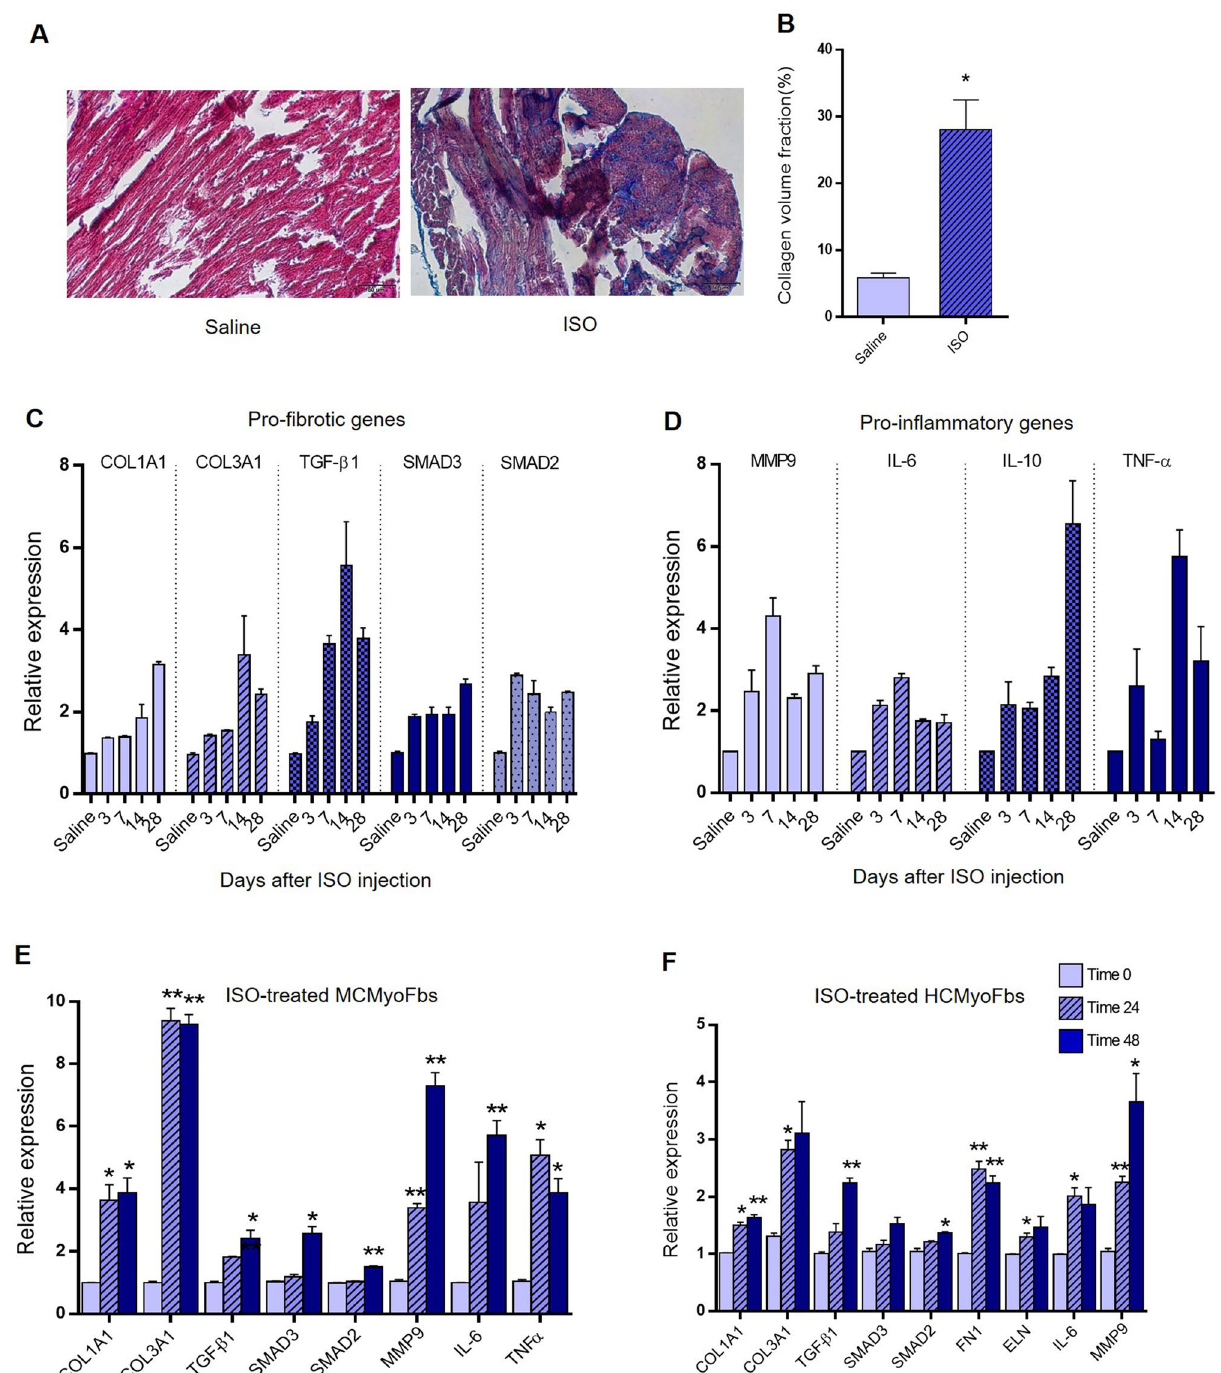
Figure 2. Induction of cardiac fibrosis in mouse model and in vitro condition using Isoproterenol. ( A ) Representative Masson’s Trichrome stain of mouse left heart sections demonstrated fibrotic tissues after ISO injection, compared with the saline group (×400) (n = 3). ( B ) The volume fraction of collagen was markedly increased in ISO treated group of mice, compared with the saline group. Collagen volume was measured using ImageJ software. ( C , D ) Shows the upregulation of fibrosis-related genes including, COL1A1, COL3A1, FN1, ELN, TGF-β1, SMAD2, SMAD3, MMP9, IL-10, IL-6, and TNFα at the mRNA levels in the mouse heart at days 3, 7, 14 and 28 following the ISO treatment (each group n = 5). ( E , F ) Profibrotic and proinflammatory genes expression were upregulated in both ISO-treated neonatal mouse and human cardiac myofibroblasts (CMyoFbs) after 24 and 48 h. Assays were performed in triplicate. Means ± SEM are shown. The asterisk mark (*) represents a p value <